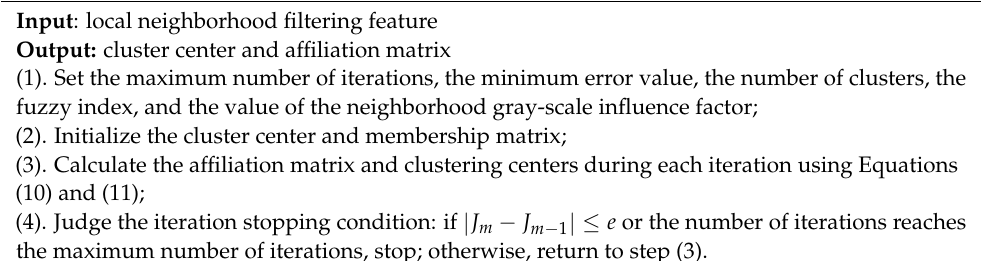
Algorithm 2: The process of the pupil clustering segmentation algorithm based on distribution information.